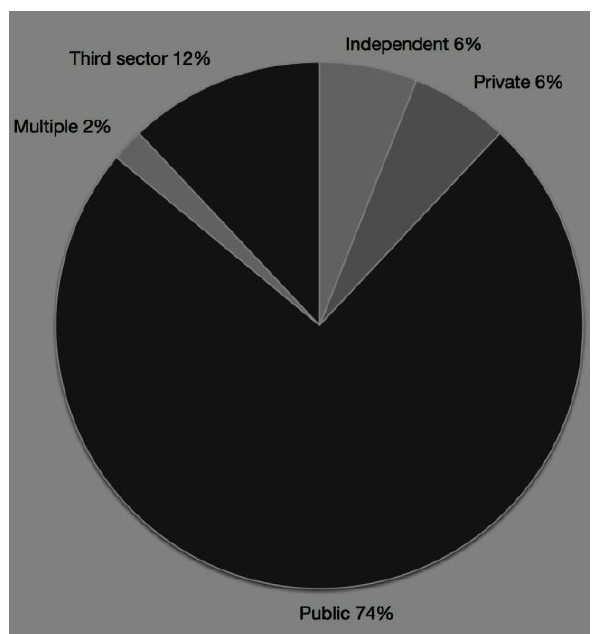
Figure 2. Main origin of the initiat